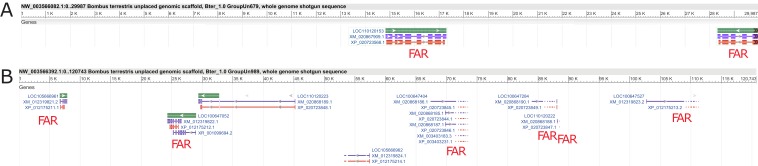
Clusters of FAR-A genes on B. terrestris genomic scaffolds Un679 (A) and Un989 (B).The horizontal axis shows genomic coordinates of genes within the scaffold. FAR genes are labeled.